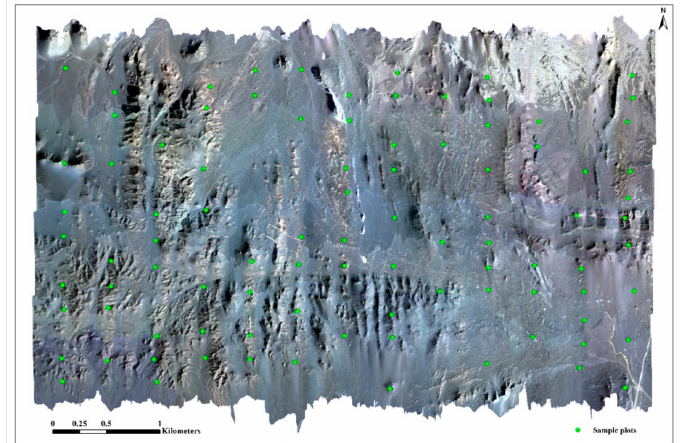
Figure 4. Map of the study region: Remote sensing image acquired using HySpex VNIR-1024 imaging sensors (Red: 641 nm; Green: 550 nm; Blue: 471 nm; spatial resolution: 1